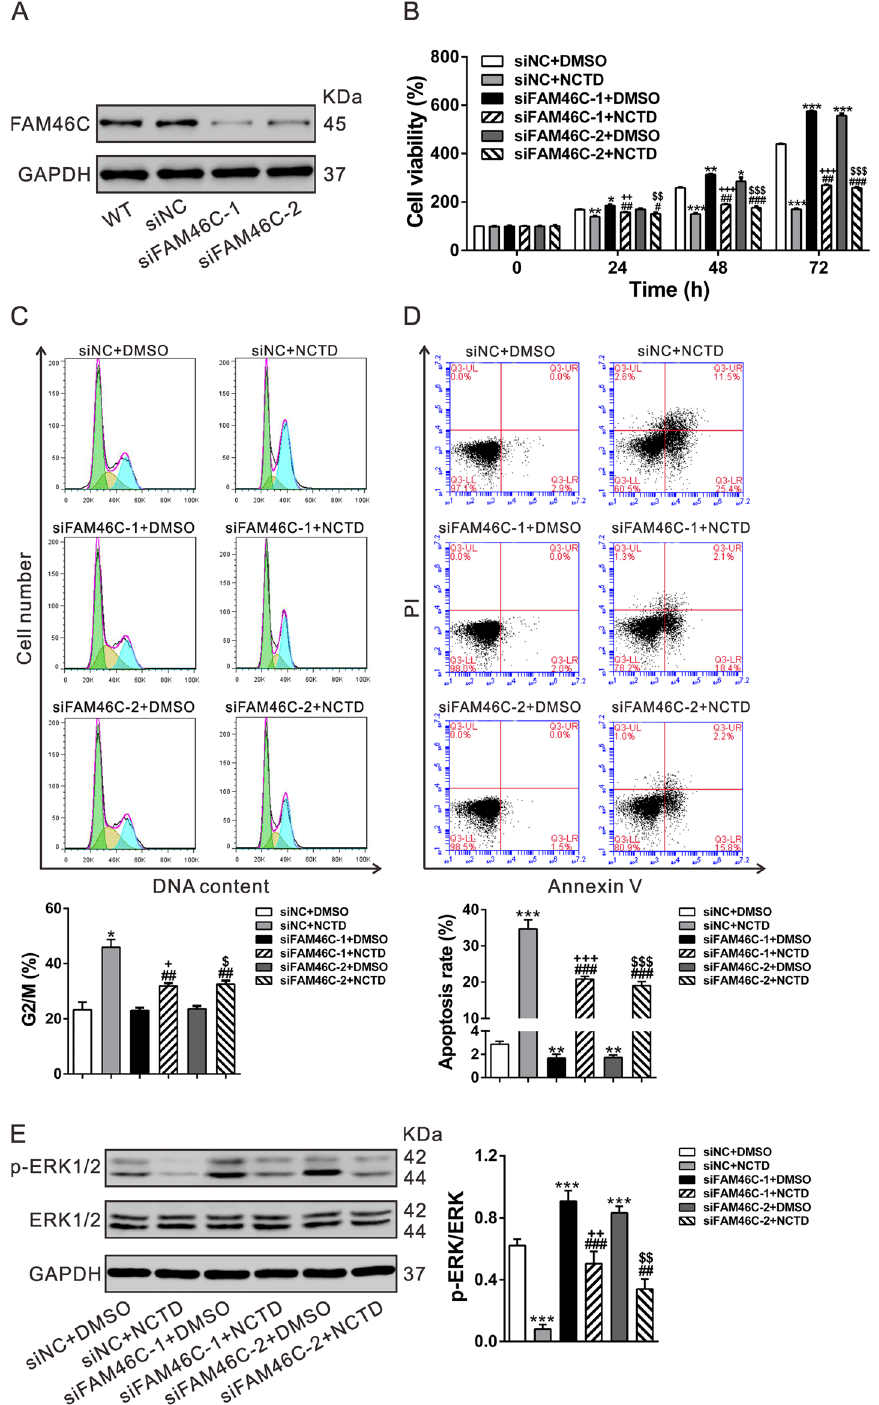
Figure 6. FAM46C is critical for the anti-cell growth effects of NCTD on HCC cells. ( A ) MHCC-97H cells were transfected with siNC, siFAM46C-1 or siFAM46C-2. At 48 h after transfection, FAM46C protein expression was detected by Western blotting. ( B,C,D ) MHCC-97H cells were divided into 6 groups: siNC + DMSO, siNC + NCTD (10 μ g/mL), siFAM46C-1 + DMSO, siFAM46C-1 + NCTD (10 μ g/mL), siFAM46C-2 + DMSO and siFAM46C-2 + NCTD (10 μ g/mL). Cell proliferation (B) was evaluated by CCK-8 assay at indicated time points. At 48 h after treatment, cell percentages in G2/M phase ( C ) and cell apoptosis ( D ) were detected by flow cytometric analysis. ( E ) Western blot analysis of ERK phosphorylation at 48 h after treatment. All experiments shown were performed independently at least three times. * P < 0.05, ** P < 0.01, *** P < 0.001 as compared with siNC + DMSO; ## P < 0.01, ### P < 0.001 as compared with siNC + NCTD; + P < 0.001, ++ P < 0.05, +++ P < 0.001 as compared with siFAM46C-1 + NCTD; $ P < 0.001, $$ P < 0.05, $$$ P < 0.001 as compared with siFAM46C-2 +